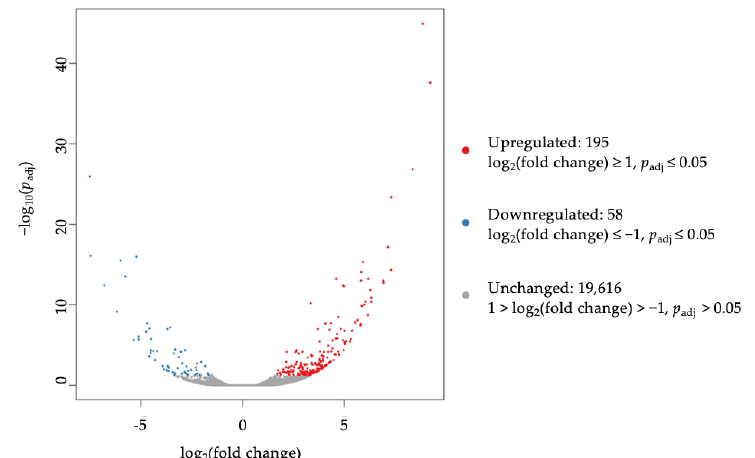
Figure 3. Volcano plot of differentially expressed genes (DEGs) between sensitive and non-sensitive colorectal cancer (CRC) cell lines. The x -axis represents the distribution of the log 2 of the fold change, and the y -axis represents the log 10 of the adjusted p -value ( p adj ). Upregulated genes are shown in red, and downregulated genes are shown in blue.